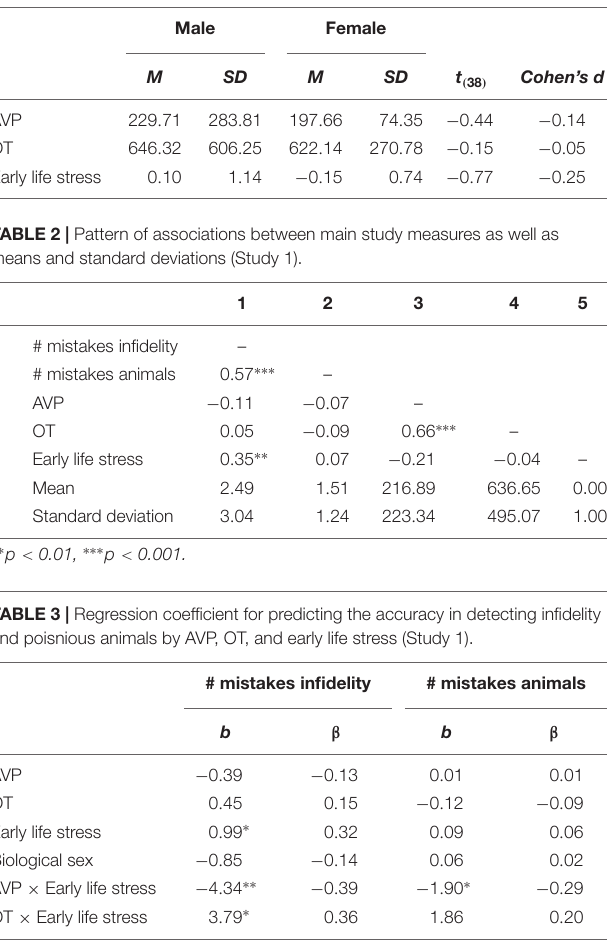
TABLE 1 | Biological sex differences in OT and AVP basal levels and early life stress (Study 1).